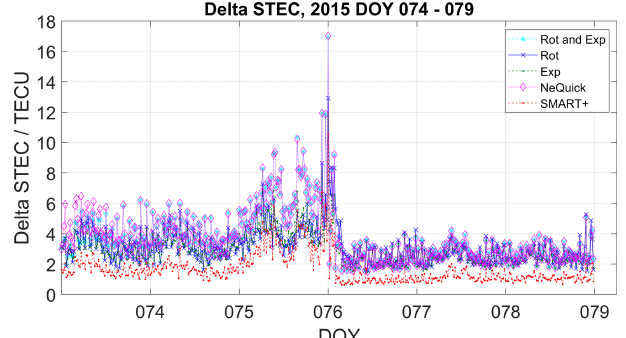
Figure 9. Plausibility check for the quiet period. (cid:49) STEC values versus time.